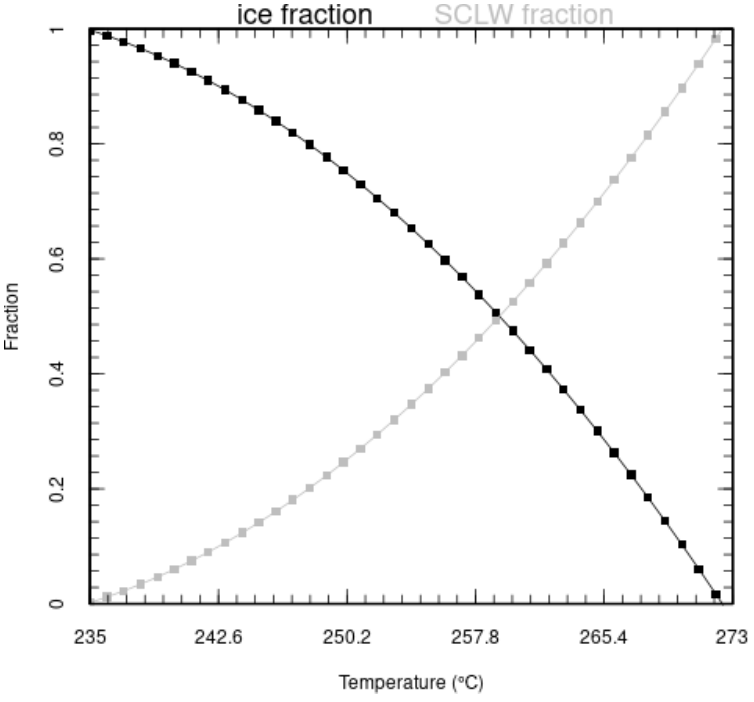
Figure A3. The SCLW and ice fraction depending on temperature.